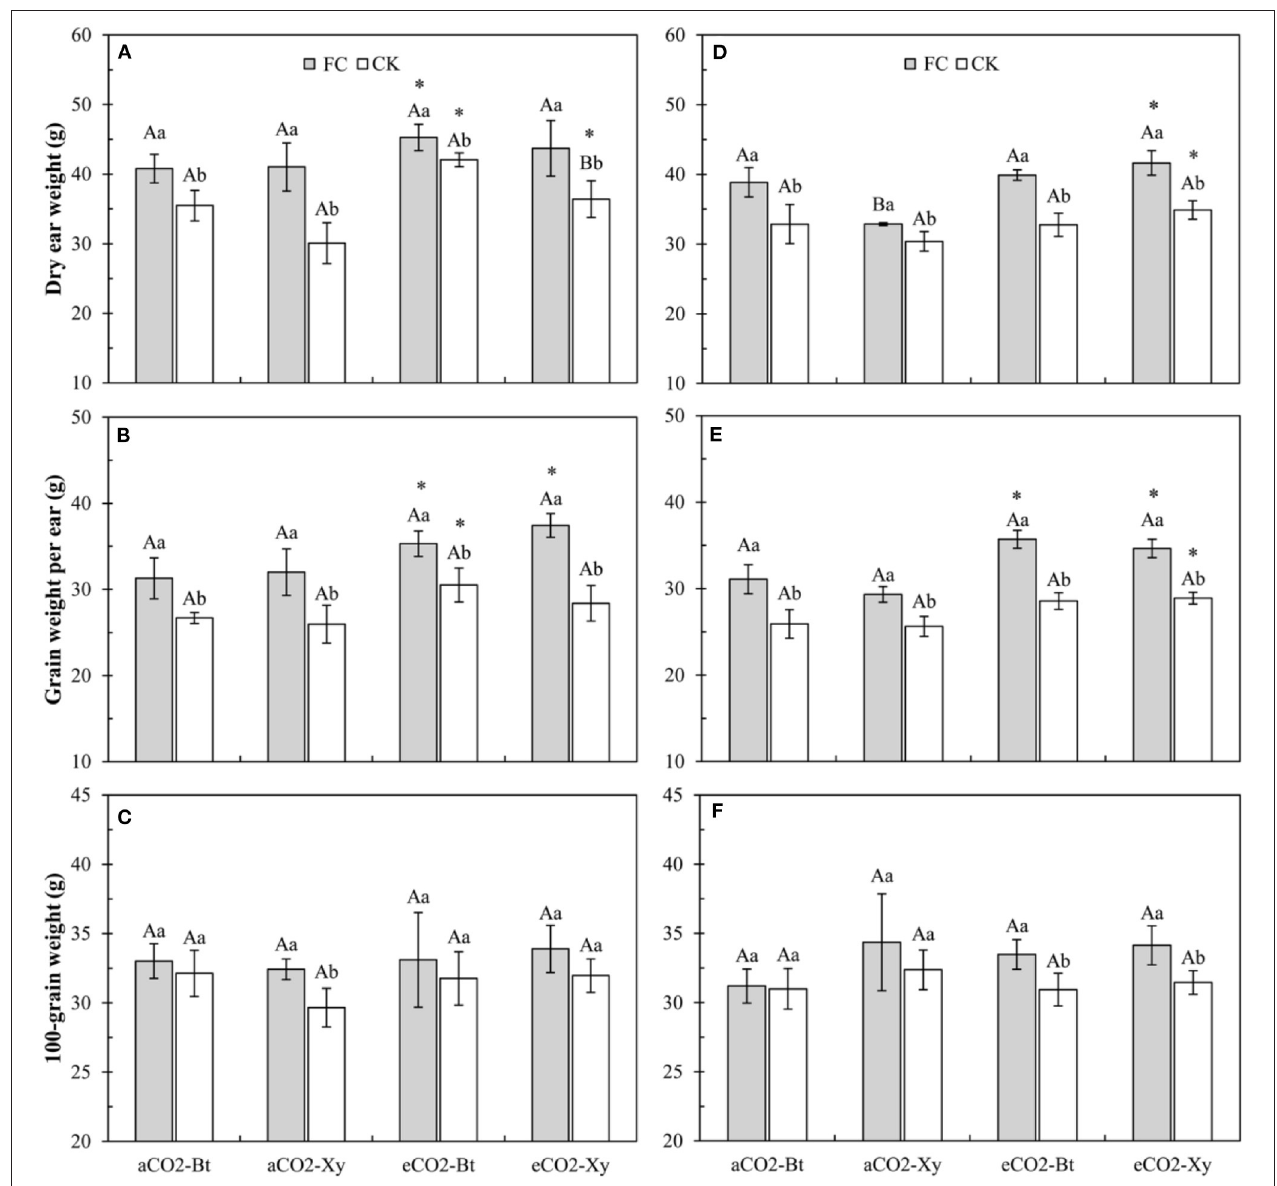
FIGURE 7 | Effects of the inoculation with arbuscular mycorrhizal fungi (AMF), F. caledonium , on the yield of Bt maize (Bt) and its parental line of non- Bt maize (Xy) under ambient CO 2 ( a CO 2 ) and elevated CO 2 ( e CO 2 ) in 2017 (A–C) and 2018 (D–F) . (Note: the same as Figure 3 ) ( P < 0.05; n =